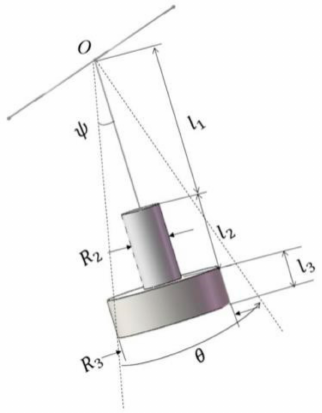
Figure 2. The structural cross-section of the vertical pendulum